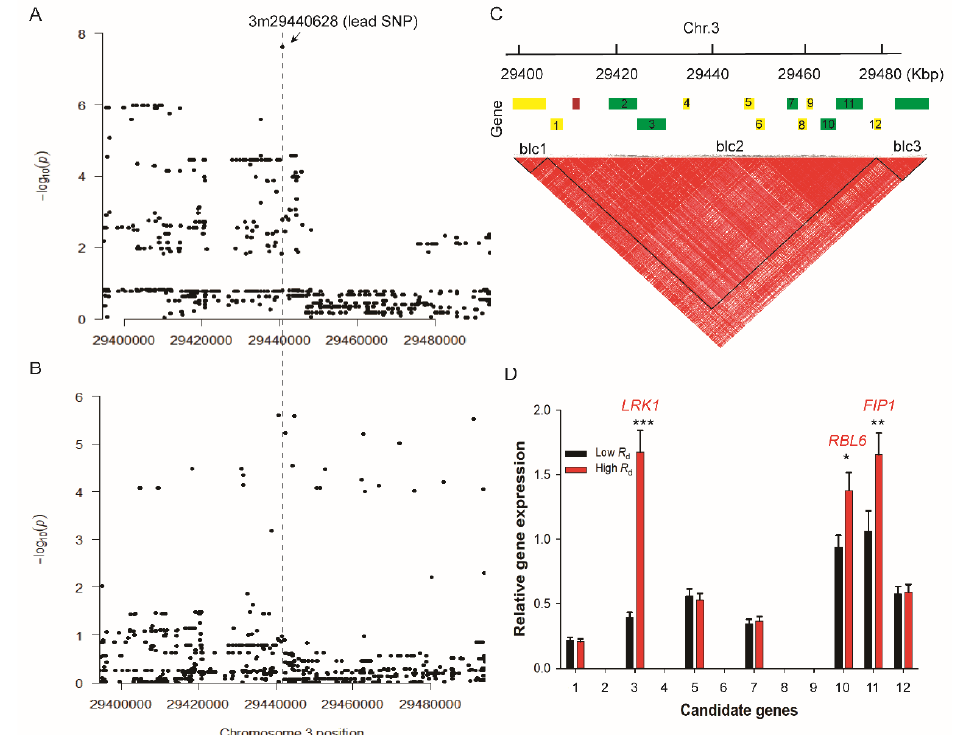
Figure 3. Haplotype analysis of the genomic regions surrounding the lead SNP. ( A , B ) Zoom-out of Manhattan plot of the R d trait to show the overlapped genomic regions in GR and field conditions, respectively. The vertical dashed-line represents the lead SNP position under both conditions (GR and field). ( C ) LD block covering 100 kb genomic regions centered the lead SNP (3m29440628) in GR. Three blocks (blcs) were obtained within this region. The numbers from 1 to 12 indicate EP1, SEC14, LRK1, EP2, EP3, EP4, MAF1, EP5, EP6, RBC6, FIP1, and EP7 , respectively. Details about genes ID according to Michigan State University (MSU) Rice Genome Annotation Project Database (http: // rice.plantbiology.msu.edu) are depicted in Table S1. Expressed, hypothetical and annotated proteins were highlighted in yellow, red, and green, respectively, according to the rice MSU database. ( D ) Relative gene expression levels of the 12 candidate genes against the housekeeping gene, actin1, in two groups of accessions, i.e., the group with high R d and the group with low R d , selected from the rice minicore panel. These 12 accessions with contrasting R d values include six accessions having high R d and six accessions with low R d . The detailed genes expressions levels for 12 accessions are displayed in Table S8. Data are means of three biological replicates performed on three di ff erent leaves obtained from di ff erent plants ±